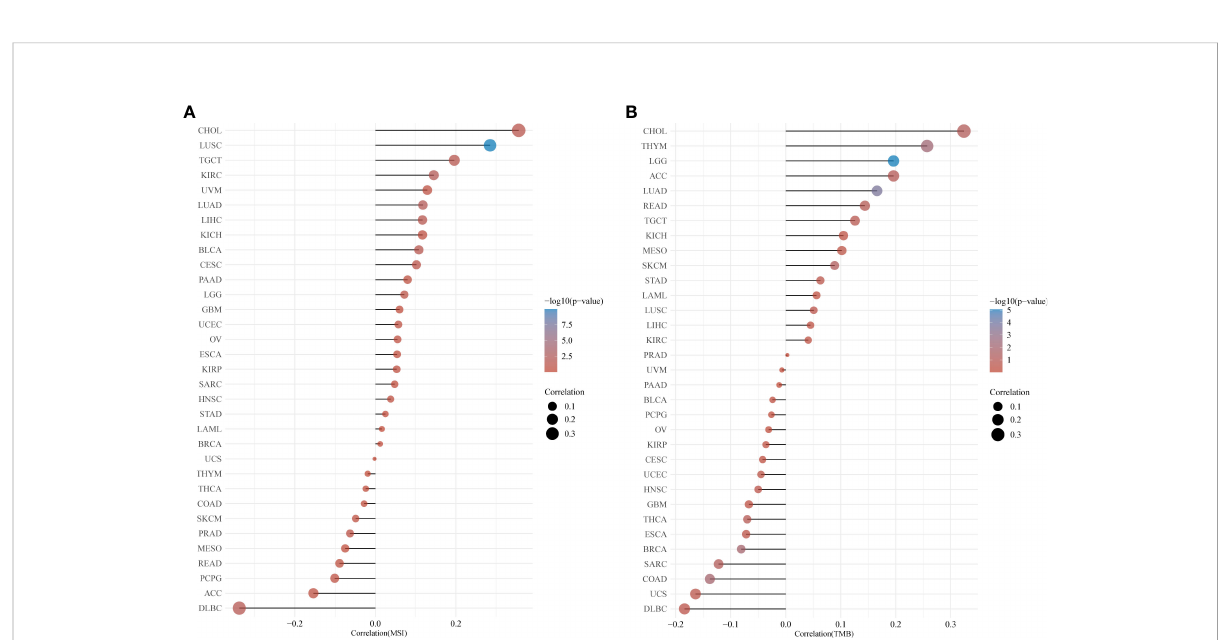
FIGURE 4 Relationship between CUL7 and TMB and MSI based on TCGA database. (A) Correlation between CUL7 and TMB. (B) Correlation between CUL7 and MSI.